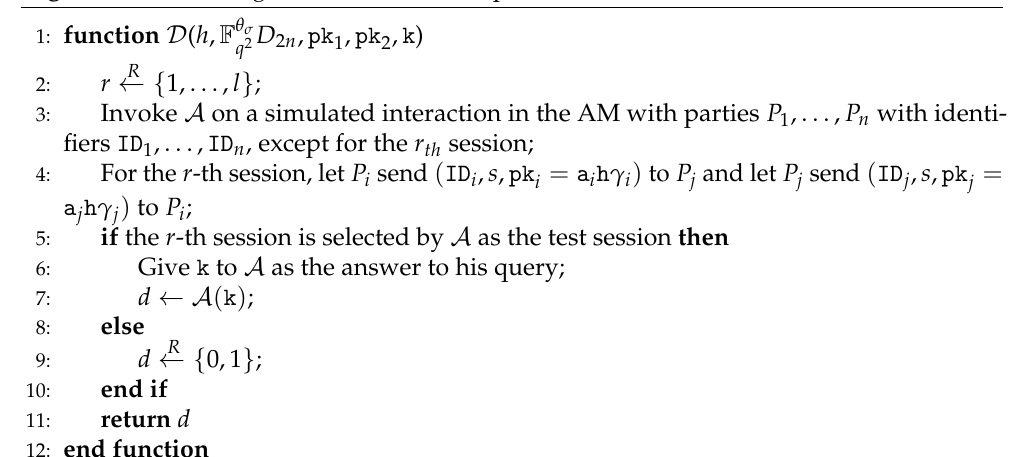
Algorithm 2 A distinguisher for the DSDP